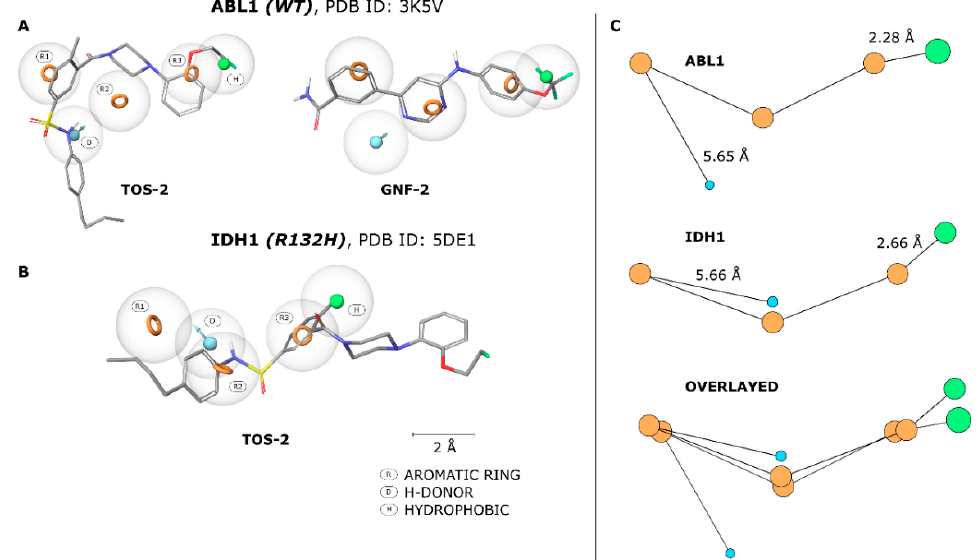
Figure 8. ( A ). TOS ‐ 2 and GNF ‐ 2 matched into the pharmacophore based on the ABL1 WT myristate binding site. ( B ). TOS ‐ 2 matched into the pharmacophore based on the IDH1 R132H allosteric site. The Figure 2. Å. ( C ). Graphic representations of the pharmacophores: the aromatic ring features are aligned to the page plane. The circle size is relative to the plane distance.